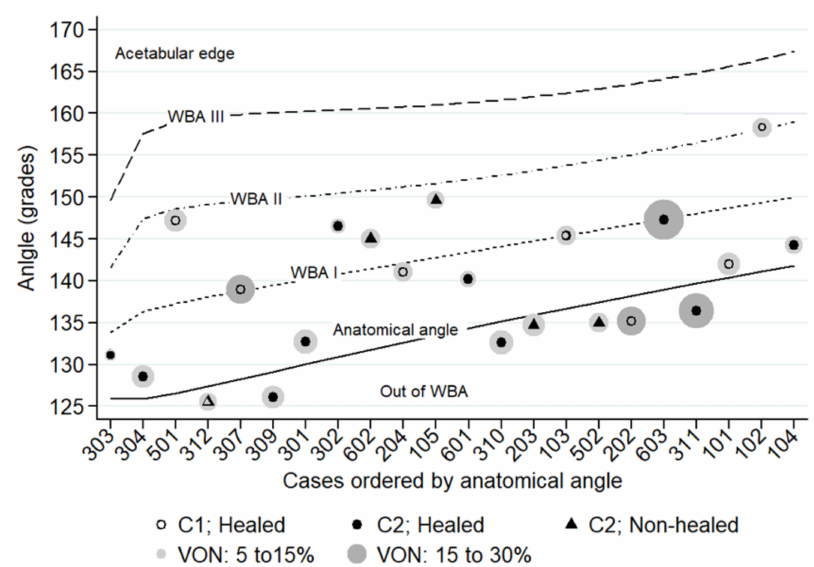
Figure 5. Distribution of the forage in the weight-bearing area, as per JIC 2001 scheme. C1: lesion occupying the three thirds of the WBA; C2: lesion occupying the three thirds of the WBA and extending laterally to the acetabular edge; VON: volume of osteonecrosis as a percentage of the femoral head (for location of the WBA, please see Figure 2).